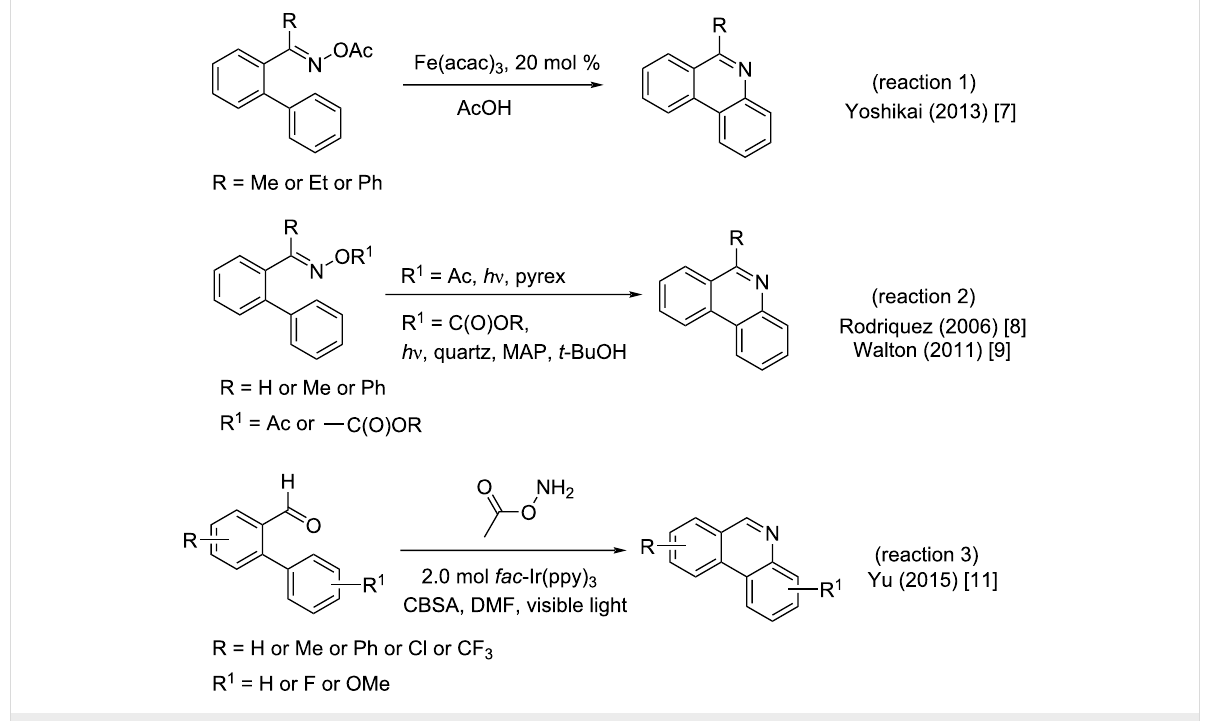
Figure 2: Synthetic routes to phenanthridines via iminyl